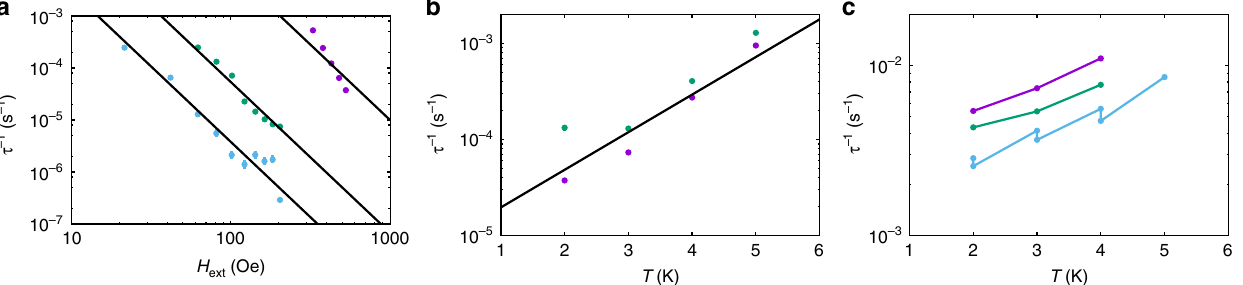
Fig. 5 Low temperature and low fi eld magnetic relaxation. a Magnetic relaxation rate measured by DC magnetometry (note the log-log scale) for 1 (purple ¼ AH (cid:1) i with i = 2.9(2), A = 5(1) × 10 3 , A = 34(3) and A = circles), 1a (green circles) and 1b (light blue circles) at 2 K; black lines are best fi ts to τ (cid:1) 1 1 1a 1b QTM 2.4(4) s − 1 Oe i . b Magnetic relaxation rate measured by DC magnetometry (note the log-lin scale) for 1 at 526(1) (purple circles) and for 1a at 79(1) (green ¼ A e jT with j = 0.9(2) K − 1 and A = 8(5) × 10 − 6 s − 1 . c Magnetic relaxation rate measured by DC magnetometry circles); black line is a best fi t to τ (cid:1) 1 QTM (note the log-lin scale) for 1 at 86(1) (purple circles), 126(1) (green circles) and 176(10) Oe (light blue circles); solid lines are a guide for the eye, there are two data points at 2, 3, and 4 K for the 176(10) Oe data, giving the appearance of a zig-zag line. Error bars are mostly within the data points